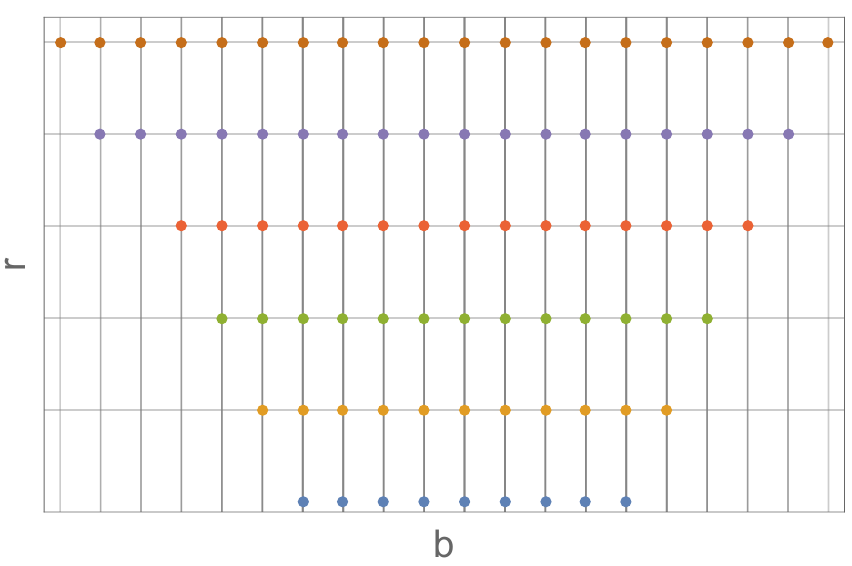
Figure 4 . For σ 1 ( r ) > 0 and falling within the window (3.18) for all r the slope of the left boundary of our region of allowed operators changes sign, resulting in an infinite set of operators for each M p scaling and a breakdown of